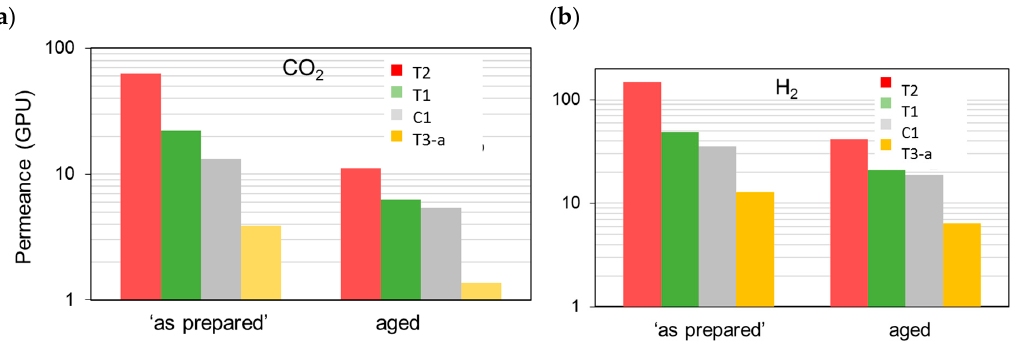
Figure 4. Permeance for the different HF samples tested “as prepared” and after long-term aging (30 months): ( a ) CO 2 ; ( b ) H 2 .